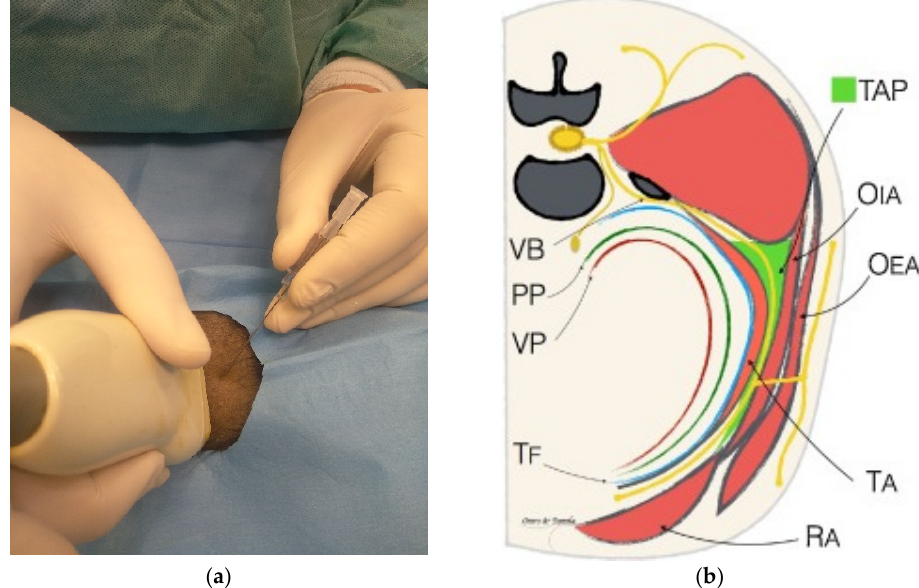
Figure 2. ( a ) Use of linear probe for the injection of a local anaesthetic into the TAP, obtaining its distribution over the thoracolumbar nerve branches located within this fascial plane. ( b ) Schematic illustration of a hemiabdomen showing the relationship of the abdominal nerves with the muscles of the abdominal wall. FT, transversalis fascia; OEA, obliquus externus abdominis muscle; OIA, obliquus internus abdominis muscle; PP, parietal peritoneum; RA, rectus abdominis muscle; TA, transversus abdominis muscle; TAP, transversus abdominis plane; VB, ventral branch of the spinal nerve; VP, visceral peritoneum [54].